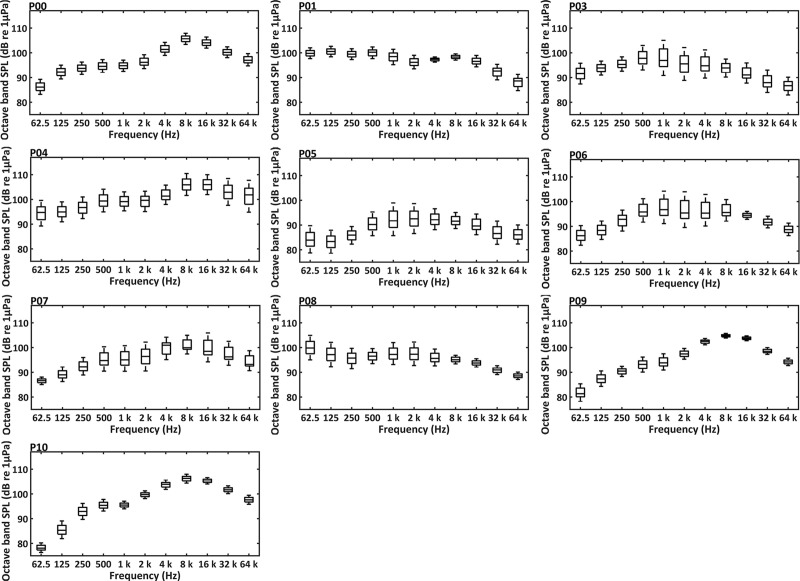
Spatial variation of octave band sound pressure levels (octave band SPLs) at different frequencies at the PAM sites.The differences of eleven octave band SPLs among ten monitoring sites (Median; Whisker: 25th–75th).